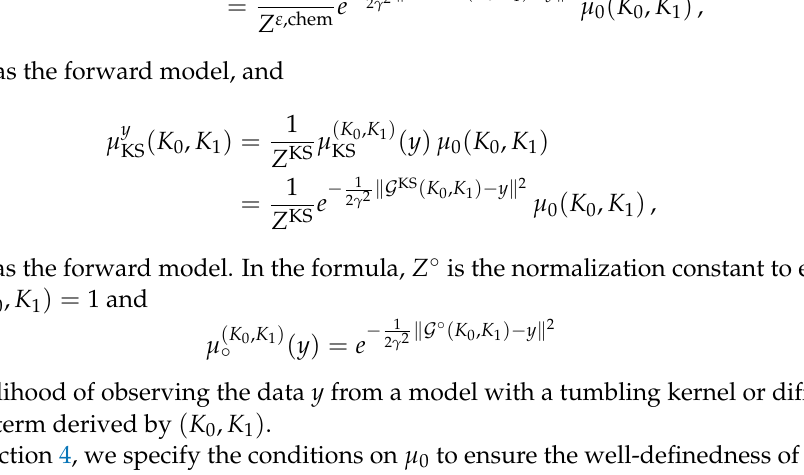
Figure 3. Two ways to determine the posterior distribution µ y tumbling